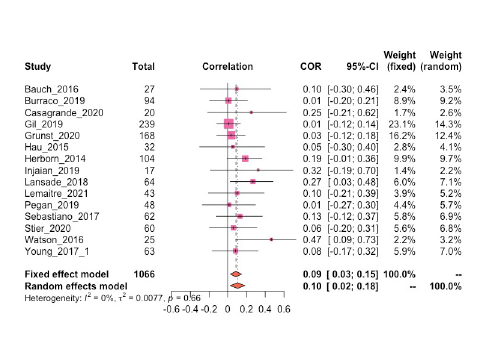
Fig 2. Forest plot. Distribution of effect sizes of GCs on telomere length and 95% CI of effect size. Dashed lines represent pooled effect sizes using a random and fixed effect model. Heterogeneity (I 2 ), the percent of variability in effect sizes that is not caused by sampling error indicates very little variability in effect size. Weight indicates the influence the study has on the overall pooled effect.